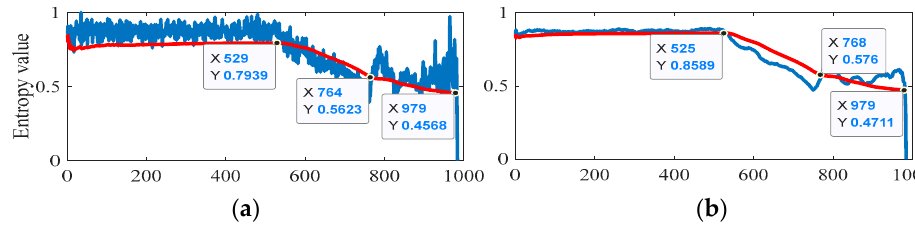
Figure 7. SDE and Smooth SDE curve (blue curve) and corresponding state warning line (red curve). ( a ) SDE; ( b ) smooth SDE.